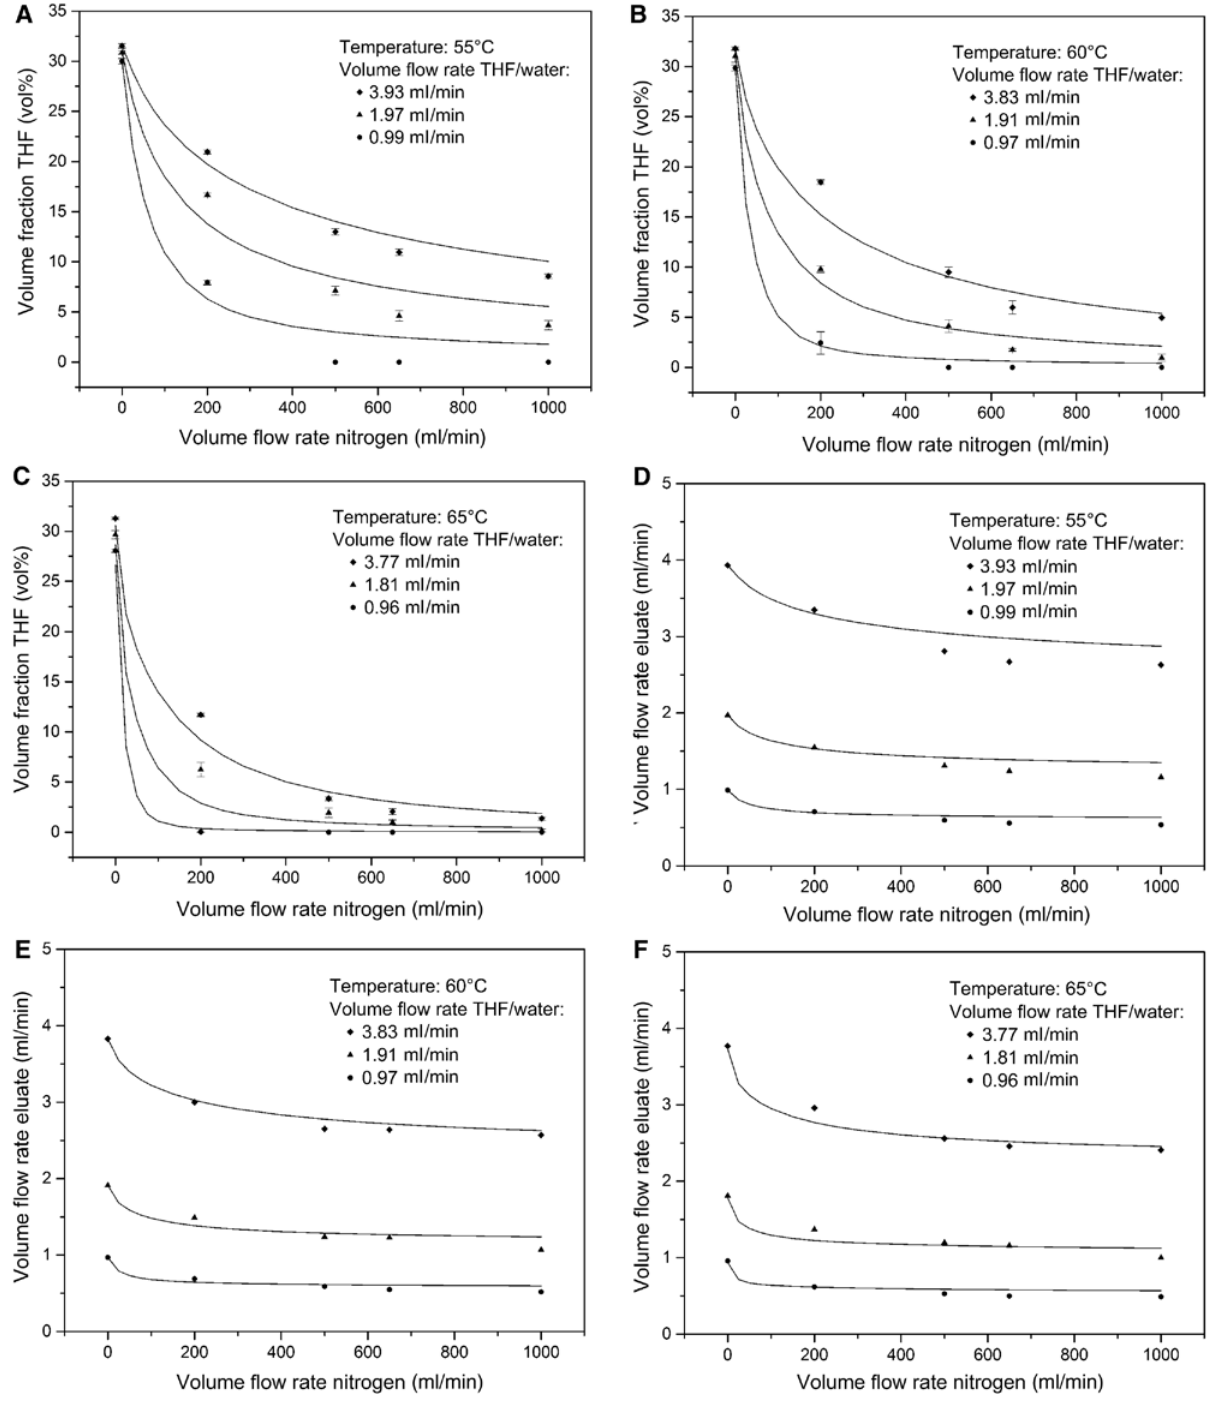
Figure 3: Liquid volume fraction of THF (left) and volume flow rate of the eluate (right), both depending on the volume flow rate of nitrogen at incoming liquid flow rates of ca. 1 ml/min, 2 ml/min and 4 ml/min and temperatures of 55 ° C, 60 ° C, and 65 ° C. The symbols represent the experimental data whereas the curves visualize the fitted model